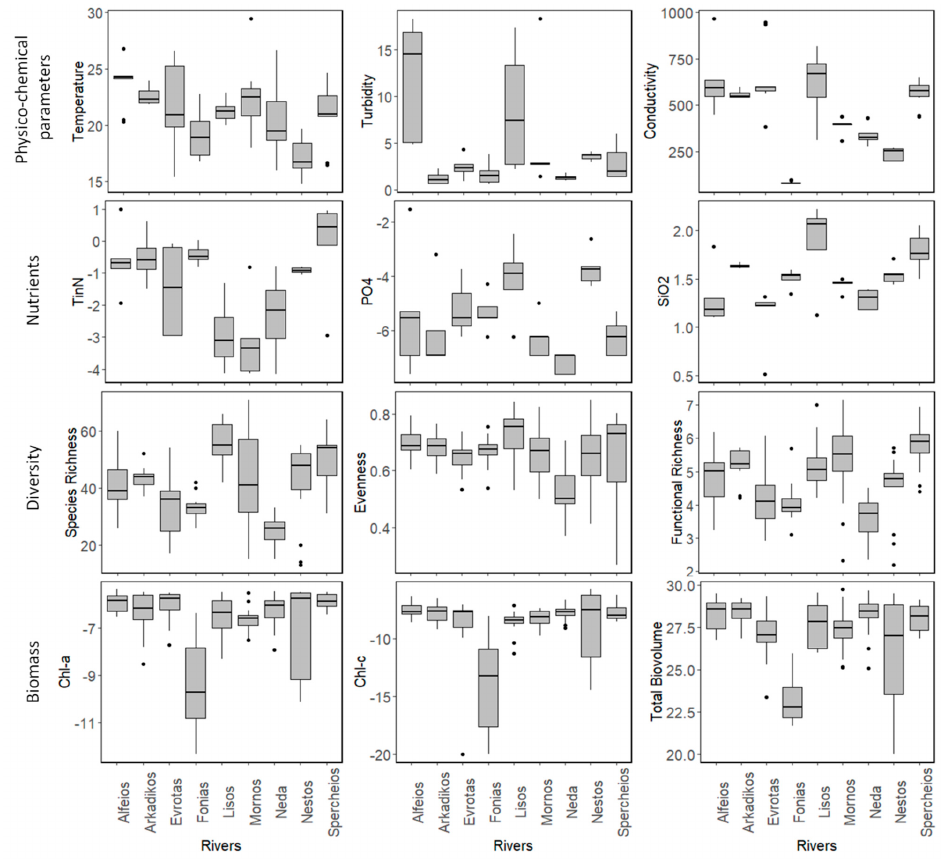
Figure A5. Physico ‐ chemical (temperature, turbidity, conductivity), nutrient concentration (Si, TN, TP), diversity (species richness, functional richness, evenness) and biomass (Chl ‐ a, Chla ‐ c, Total biovolume) variation between the nine rivers of the study. Table A1. Coordinates and sampling dates of each site. Site numbers 1–5 correspond to sites from upstream to downstream.